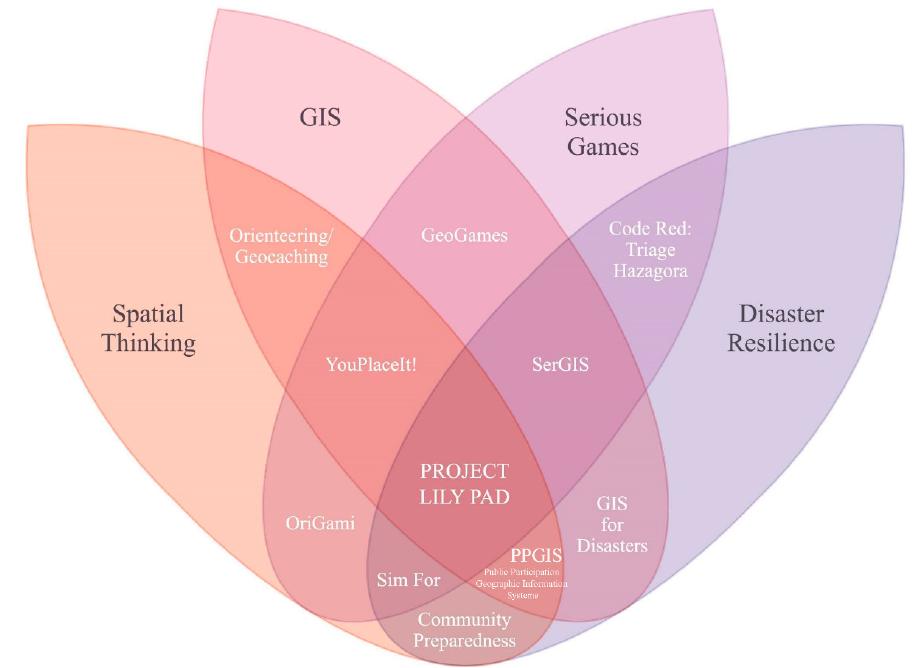
Figure 1. A diagram showing how ideas from the four focused concepts examined through the scoping literature review were used to develop a research conceptual framework.